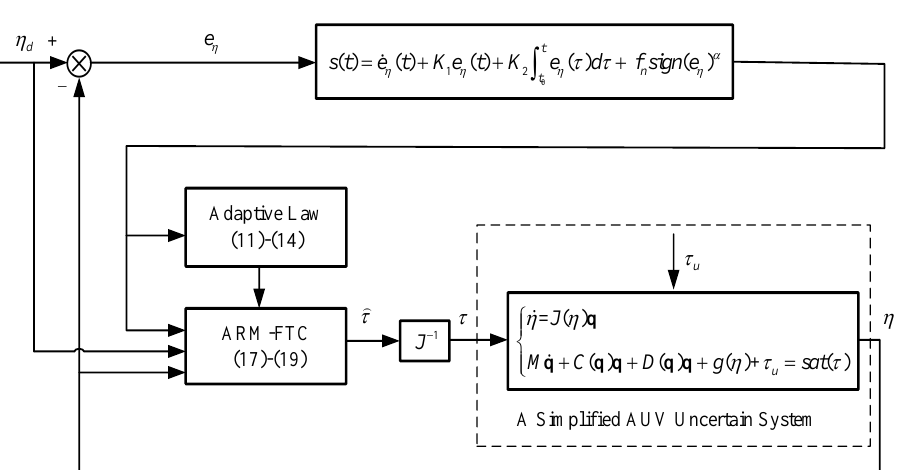
Figure 2. Overall control block diagram of a simplified AUV uncertain system.